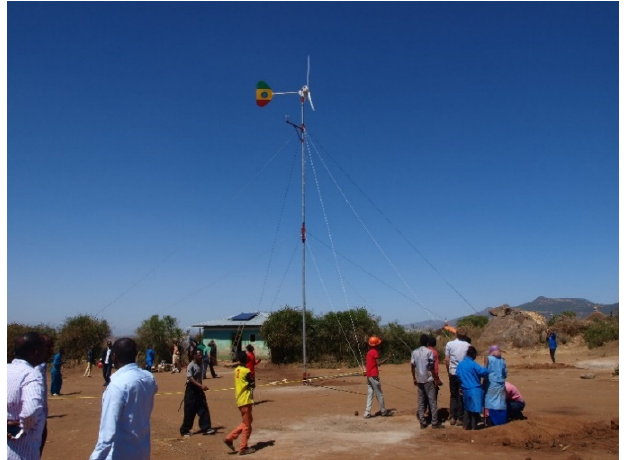
Figure 3. The 3 m wind turbine installed next to the shop in Handew. Reprint with permission, rurerg.net (accessed on 24 May 2022).